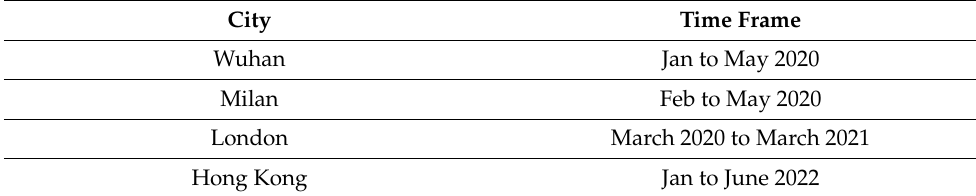
Table 3. Time frame of study and COVID-19-related information. City Time